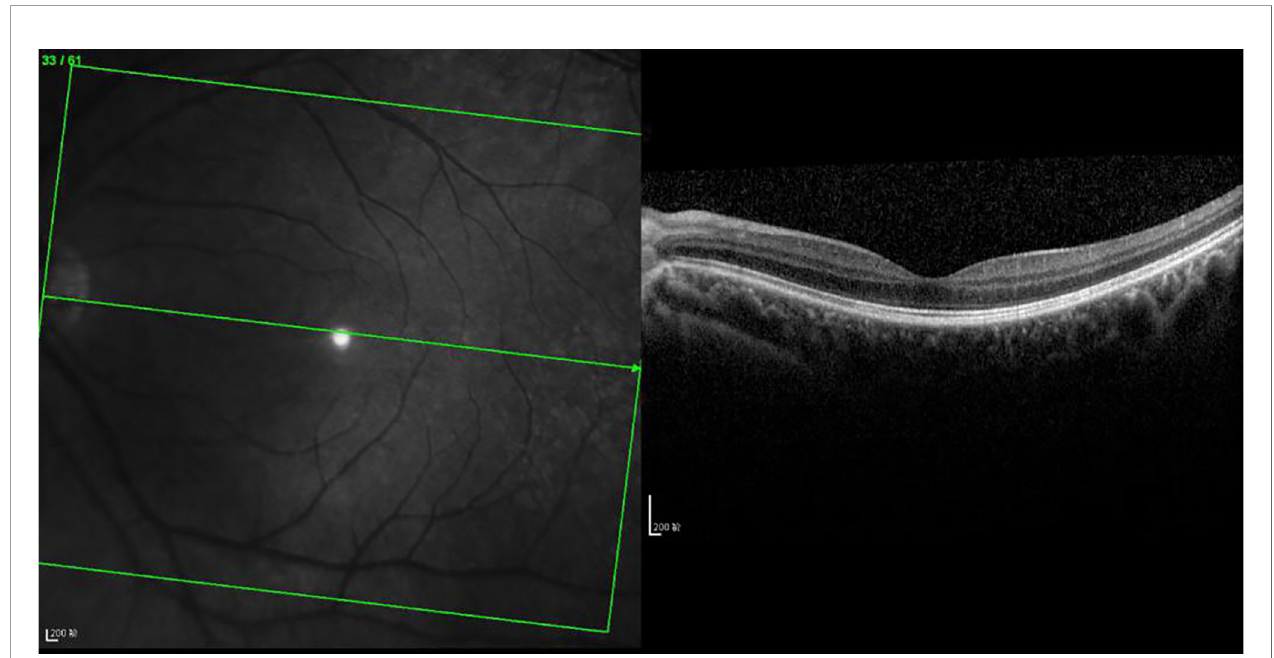
FIGURE 4 | OCT scanning of the ocular fundus in an individual without DRME. There is no edema in the macular area, the CFT value is 231 m m, and the ELM layer and IS/OS layer are continuous.